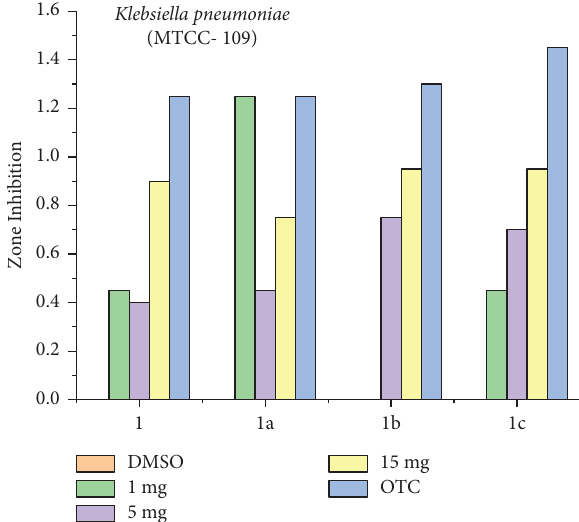
Figure 4: Radius of the zone of inhibition (mm) against S. aureus (MTCC-103) in the range of 1–15mg/mL sample ( 1 , 1a , 1b , and 1c ) with positive control of 50mg/mL oxytetracycline.